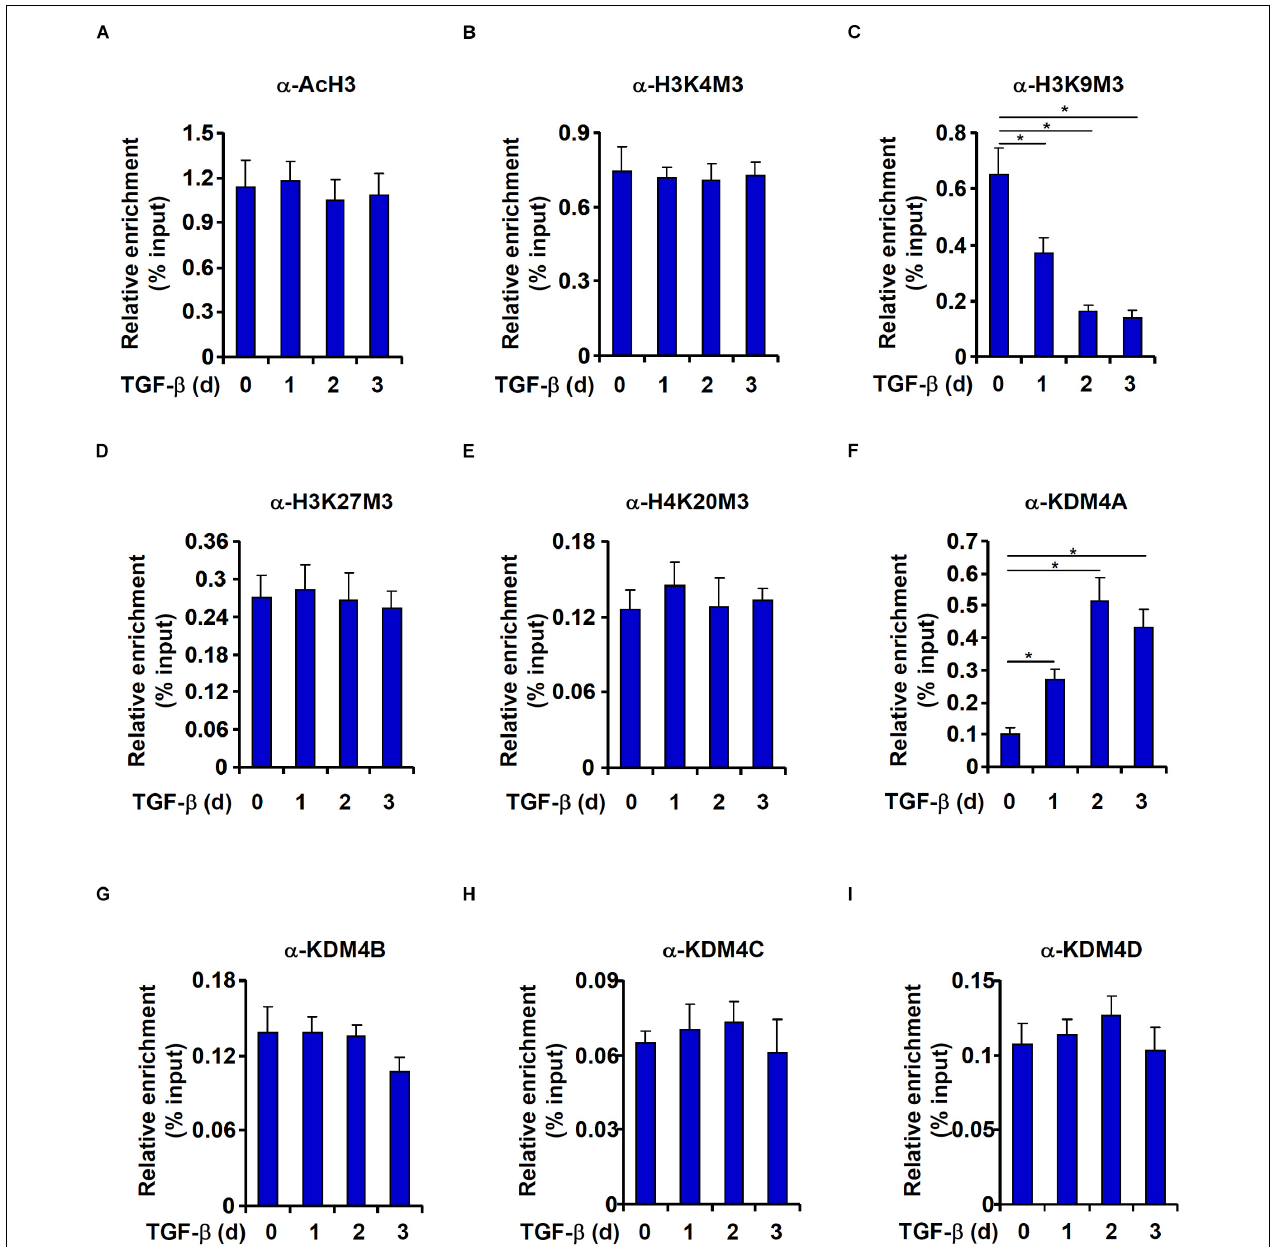
FIGURE 4 | TGF- β promotes KDM4A recruitment to the DBC1 promoter. (A–I) IEC-6 cells were treated with TGF- β (2 ng/ml) and collected at indicated time points. ChIP assays were performed anti-acetyl H3, anti-trimethyl H3K4, anti-trimethyl H3K9, anti-trimethyl H3K27, anti-trimethyl H4K20, anti-KDM4A, anti-KDM4B, anti-KDM4C, or anti-KDM4D. All experiments were performed in triplicate wells and repeated three times. One representative experiment is